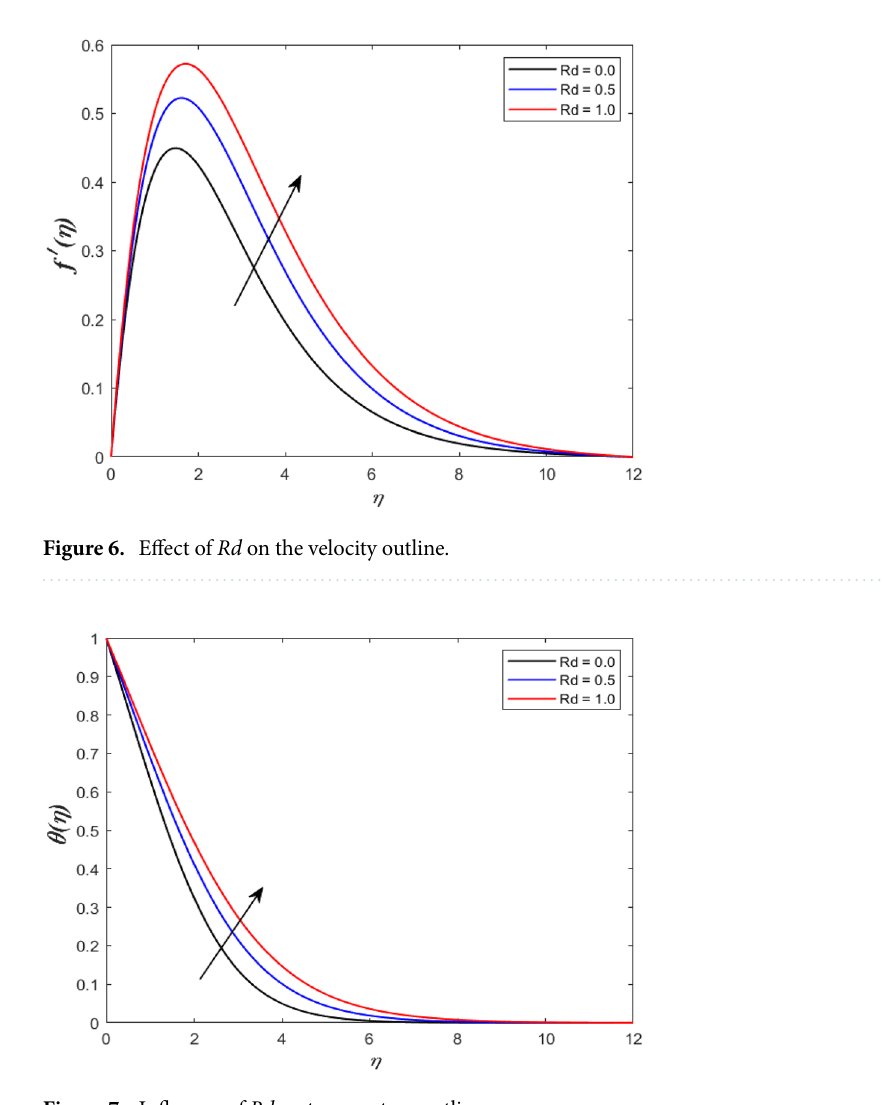
Figure 7. Influence of Rd on temperature